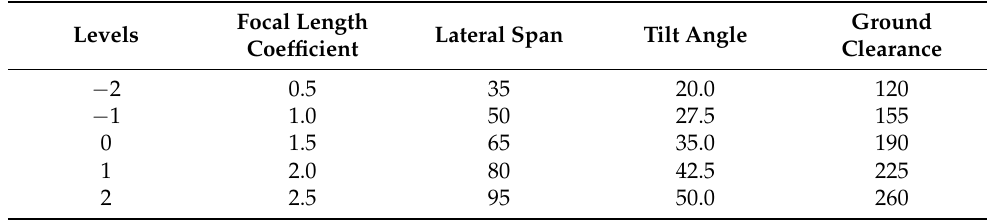
Table 4. Test schemes and